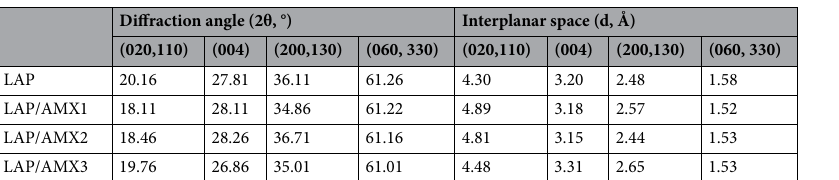
Table 1. Diffraction angles and interplanar space values from XRD spectroscopy.